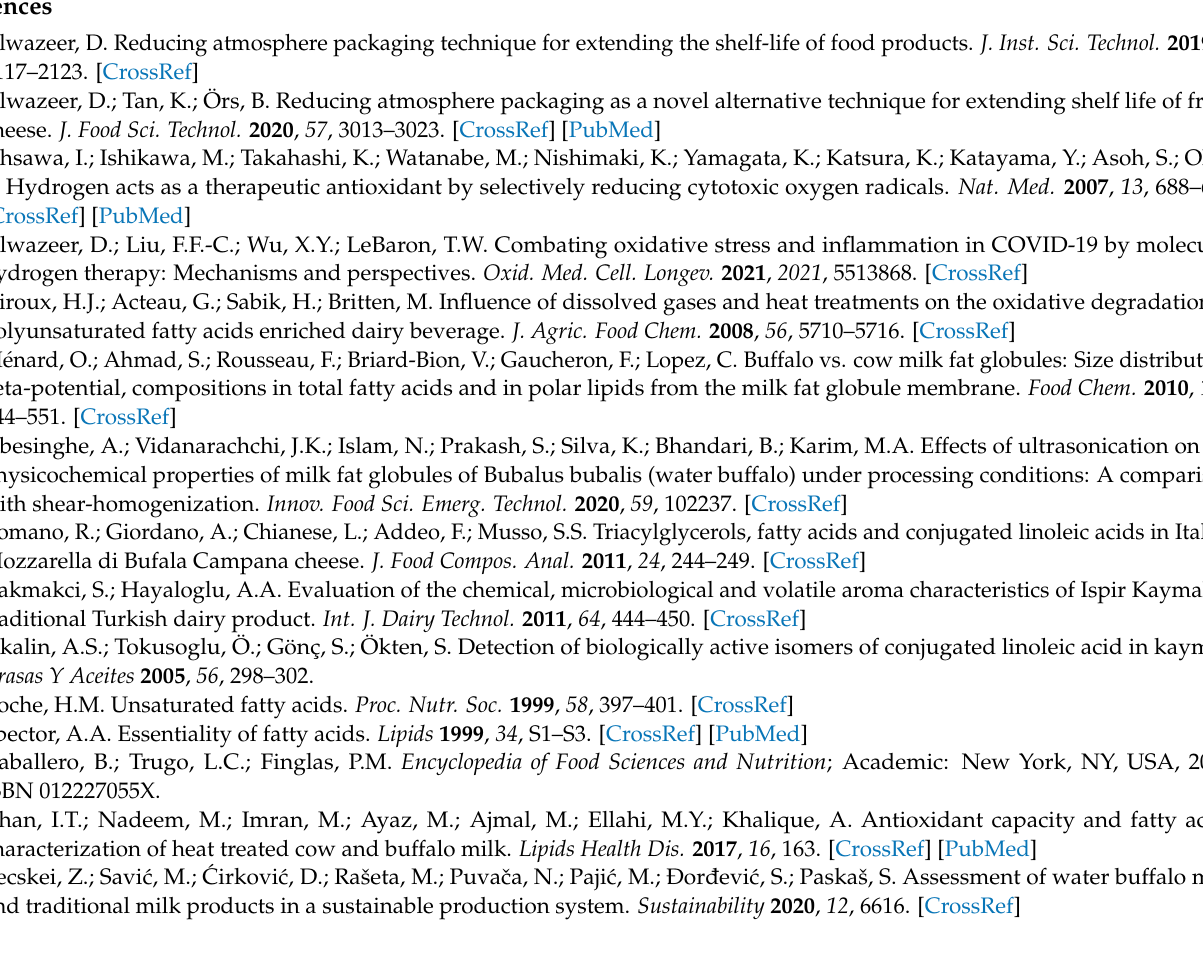
CC samples; Table S2: Fatty acid compositions (%) of CC samples (mean ± standard deviations, n = 2); Table S3: Free fatty acid concentrations (mg/kg) of CC samples (mean ± standard deviations, n =